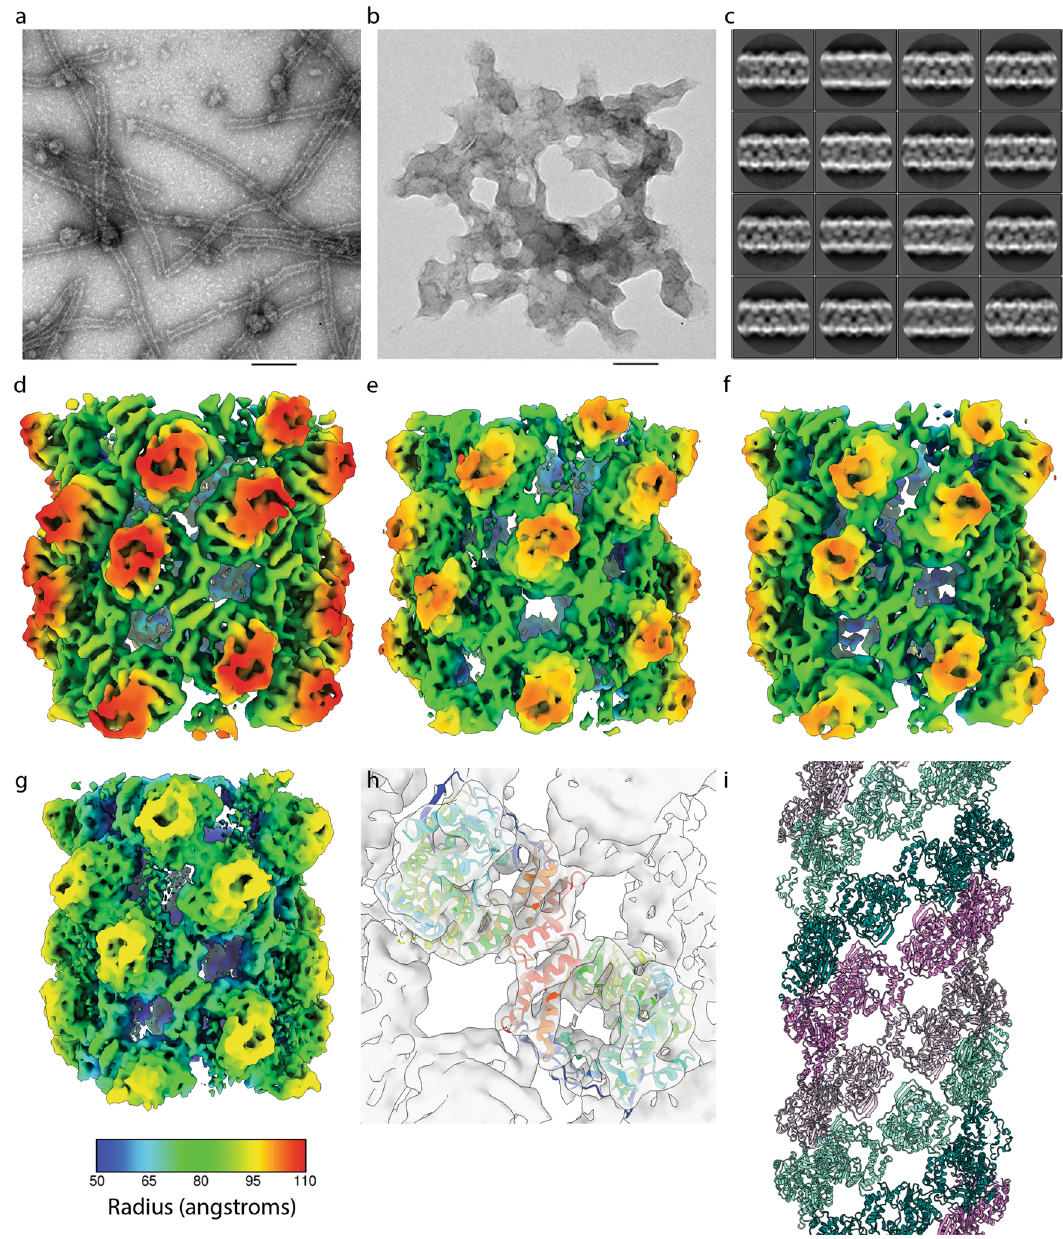
Fig. 4 Structure of 3D pol fi brils. Negative stain TEM of a sample from a polymerase activity assay in the presence of glutaraldehyde after 30-minute incubation. a 3D pol -WT forms visible fi brils, b 3D pol -GNN does not show any distinct fi bril structure formation. Scale bar 100 nm. c 2D classi fi cation and averaging of fi bril section images from cryo-EM data shows variation in fi bril diameter. d – g Helical reconstruction led to the calculation of density maps for nine classes of fi bril at 7.3 – 9.5 Å resolution, four representative maps are illustrated here coloured according to radius (see key below panel g ). d The broadest fi bril reconstruction; B1 had a diameter of 22.3 nm, C2 symmetry, a helical twist of 39 o and an axial rise per subunit of 27 Å. e Conformation B2 has a more open structure, is also C2 symmetric and has a diameter of 21.7 nm, twist of 40 o and rise of 31 Å. f N3 is a narrow (Ø = 21.5 nm) and tightly packed fi bril which may also be described by a 1-start helical symmetry with a twist of -158.8 o and axial rise of 15 Å. g N9 is a narrow, open fi bril structure having a diameter of 20 nm, twist of -158.6° and axial rise of 17.4 Å. h Fitting of the X-ray structure for 3D pol -WT in complex with template primer RNA and ATP (PDB: 2EC0) into each density map shows that these fi brils are two-start helical lattices comprising proto fi laments of 3D pol dimers. i Proto fi lament one is coloured violet/thistle, while proto fi lament two is coloured teal/aquamarine, two shades are used in each proto fi lament to highlight how 3D pol monomers form ribbons of fi brils we use a notation incorporating the ‘ palm ’ , ‘ fi ngers ’ , and opposite proto fi lament (and n ’ + 1 its partner within a dimer). For conformations N3-N9 the transformation from n to n + 1 thumb ’ subdomain nomenclature, while the relative spatial and all subsequent increments is de fi ned by the left-handed 1- organisation of monomers within the helix are denoted as follows. start helical parameters: a rotation of ∼ -158° and an axial rise of Where n represents a monomer and then n ’ is the twofold ∼ 15 – 17 Å. For the C2 symmetric broad fi brils, which do not show 1-start helical symmetry, the transformation from n to n + 1 (and (Fig. S4). Here, n + 1 represents the next monomer, on the